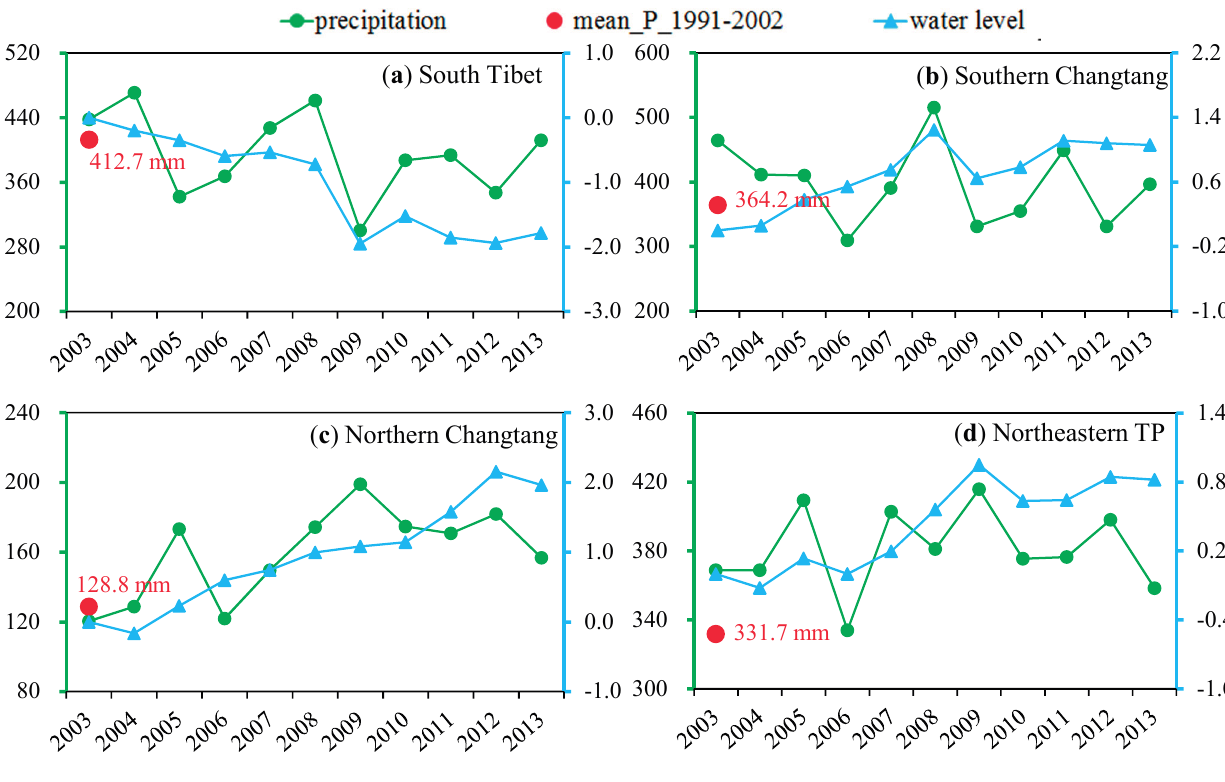
Figure 4. Comparison of time series of annual precipitation (P, left axis: mm) and lake level anomaly (water level variations relative to the initial water stage in the studied period) (right axis: m) between 2003 and 2013 for four different sub-zones: ( a ) South Tibet; ( b ) Southern Changtang; ( c ) Northern Changtang; and ( d ) the northeastern Tibetan